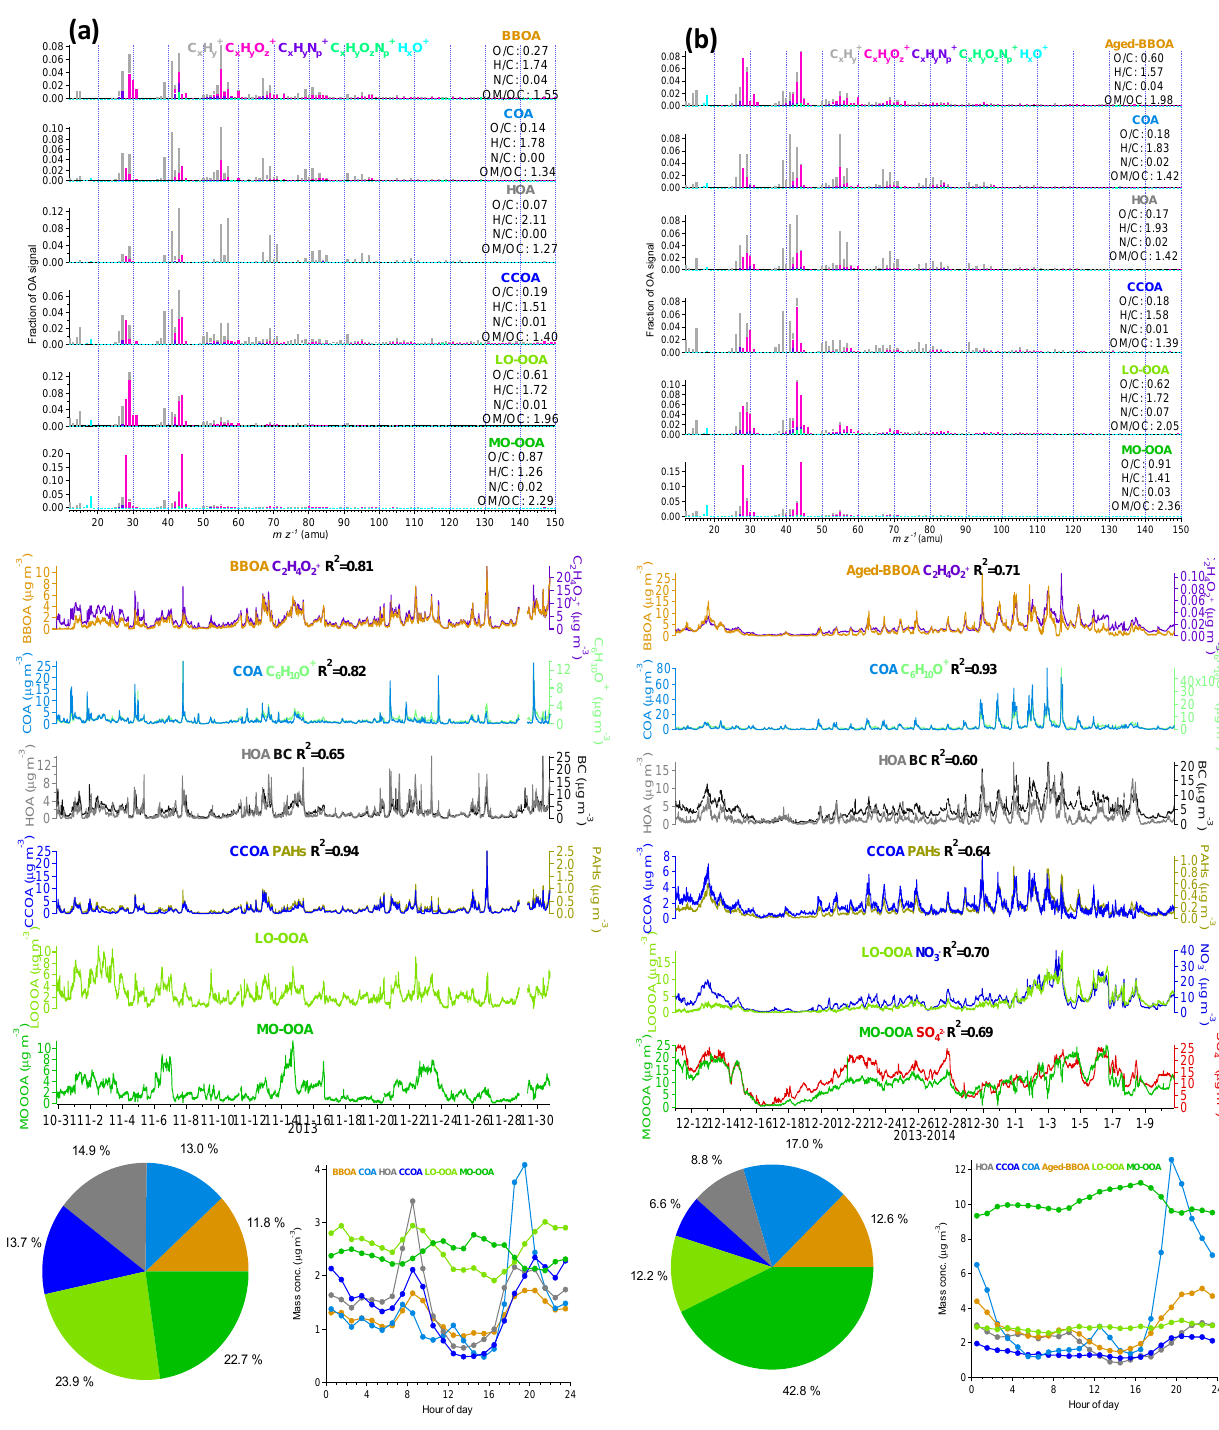
Figure 3. Mass spectra of the OA factors, average fractions of the OA factors, diurnal variations of the OA factors and time series of the OA factors identified by the ME-2 method for (a) Qingdao and (b)